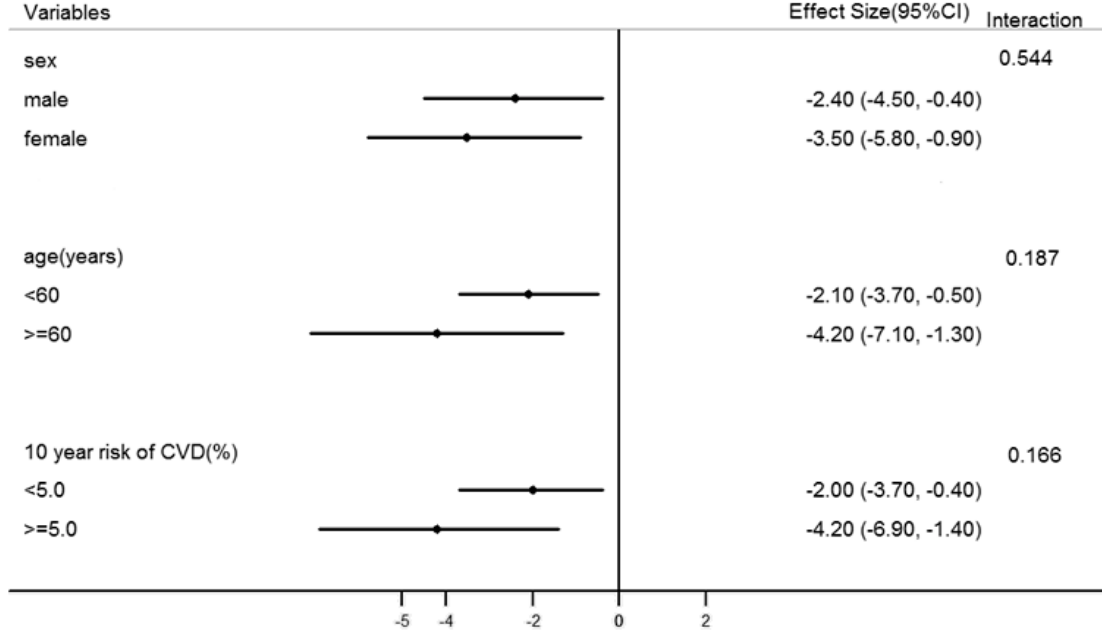
Figure 2. Effect size by subgroup analysis for 10-year risk of Figure 2 . Effect size by subgroup analysis for 10-year risk of CVD